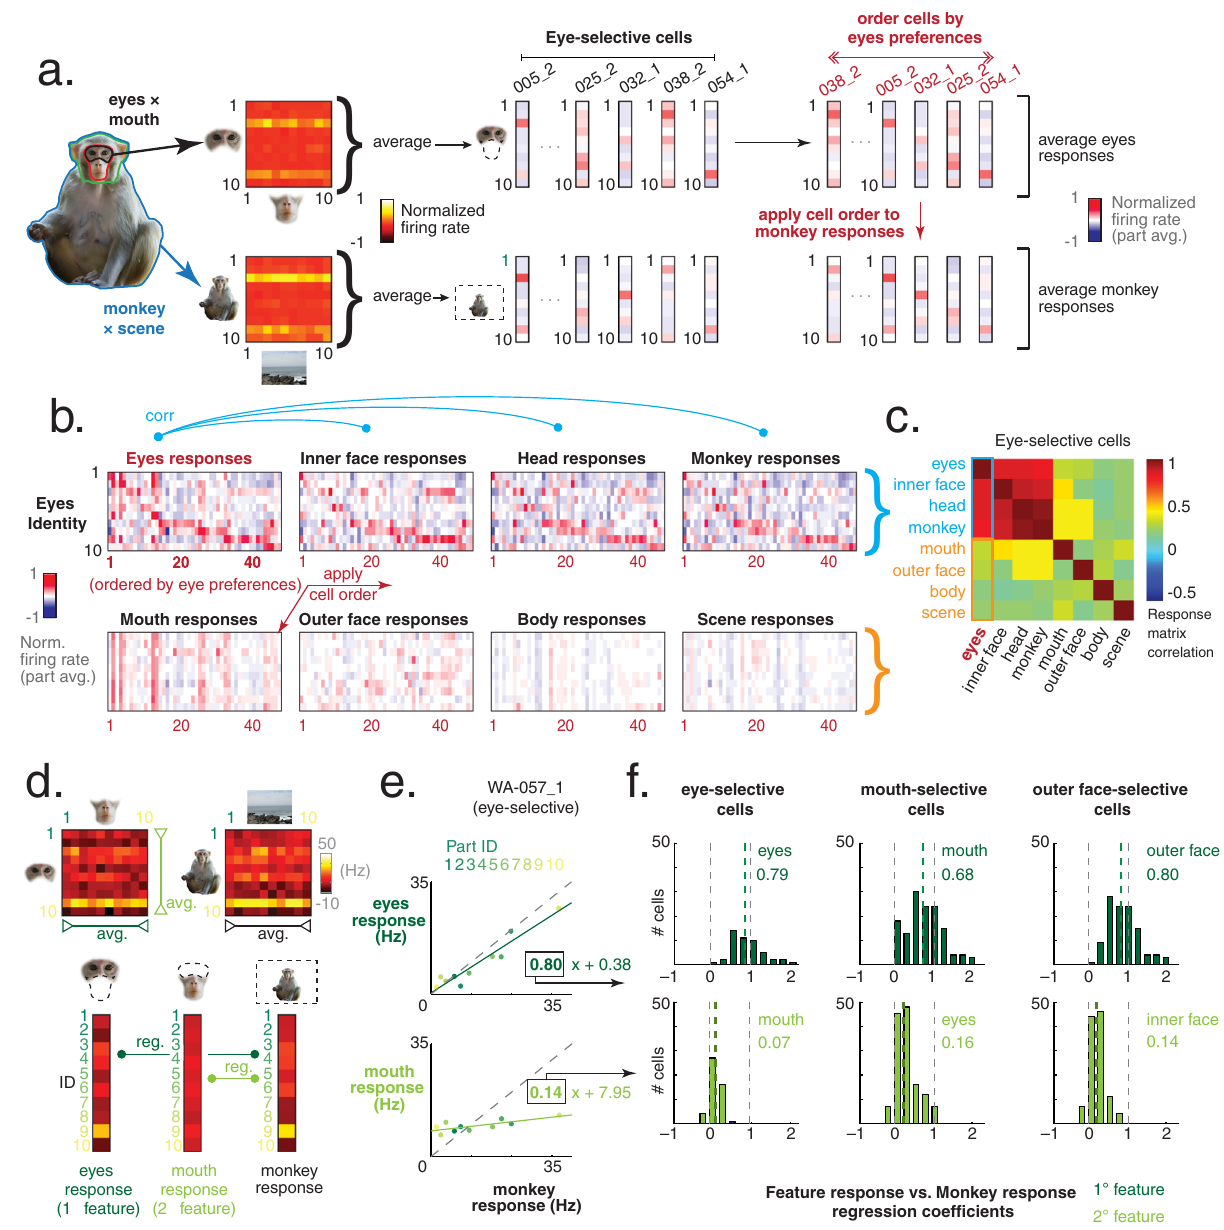
Fig. 4 | The responses to local parts predict responses to full naturalistic images. a Eyes-selectivecells:Fromresponsesto eye×mouth and monkey×scene stimuli, average eyes and average monkey responses. Population ordered by the cells ’ eye identity preferences; cell order subsequently applied to the monkey responses. b Eyes-selective cells: Heatmaps of average fi ring rates for each local part.Asin a ,cellsineachresponsematrixareorderedbyeyesidentitypreferences. c Eyes-selective cells: Pairwise correlations between part response matrices. Cor- relations between eyes responses and sorted inner face, head, and monkey response matrices are high (top row in b , outlined in blue). Correlations between eyesresponsematrixand sorted mouth,outerface,body,and sceneresponsesare lower(bottomrowin b ,outlinedinorange). d Eyes-selectivecellWA-057_1:Average responses to eyes and mouths; compared to average response for